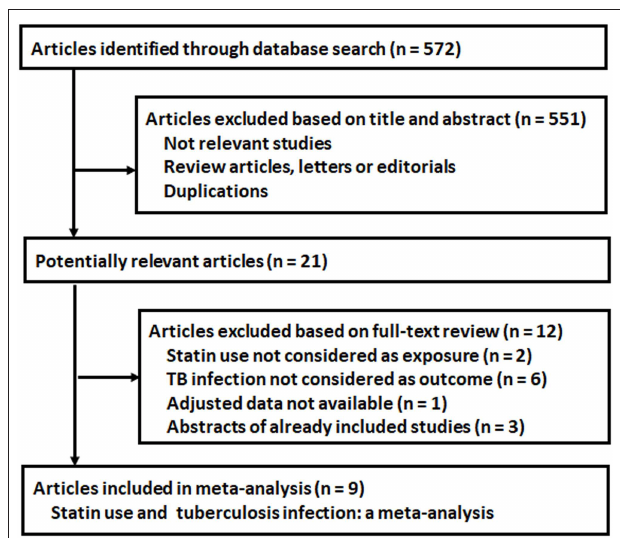
FIGURE 1 | Flowchart of database search and study identification.